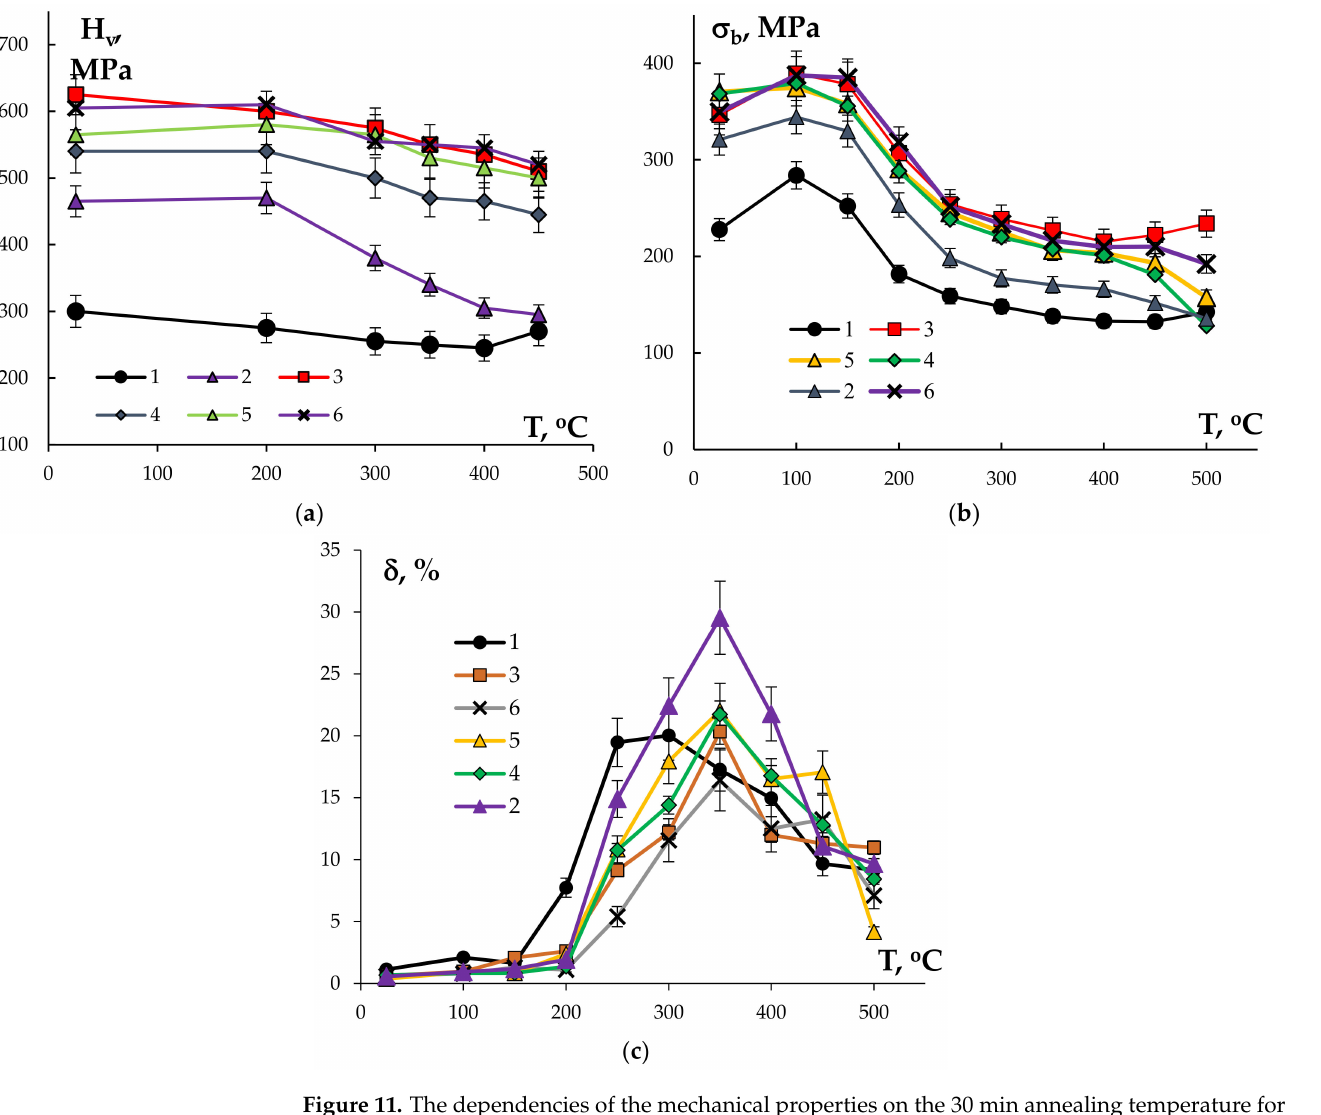
Figure 11. The dependencies of the mechanical properties on the 30 min annealing temperature for the sample bimetallic wires: ( a ) microhardness (H v ); ( b ) ultimate strength ( σ b ); and ( c ) elongation to failure ( δ